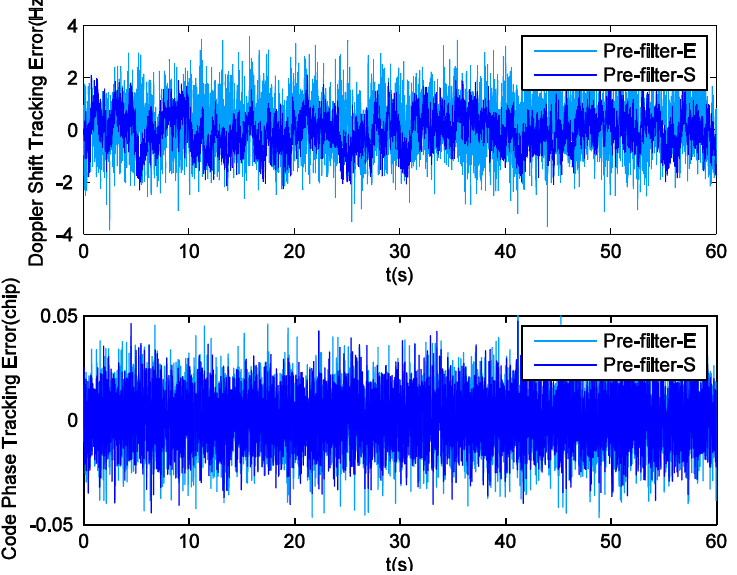
Figure B1. Tracking errors of pre-filter-E and pre-filter-S. Figure A1. Tracking errors of pre-filter-E and